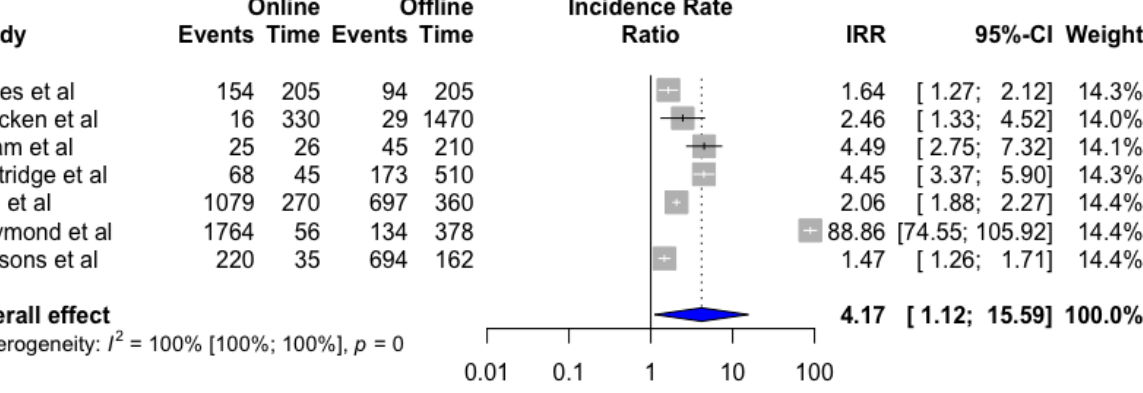
Figure 2. Recruitment rate for active days of enrollment for online and offline recruitment. Value <1, in favor of offline recruitment; value >1, in favor of online